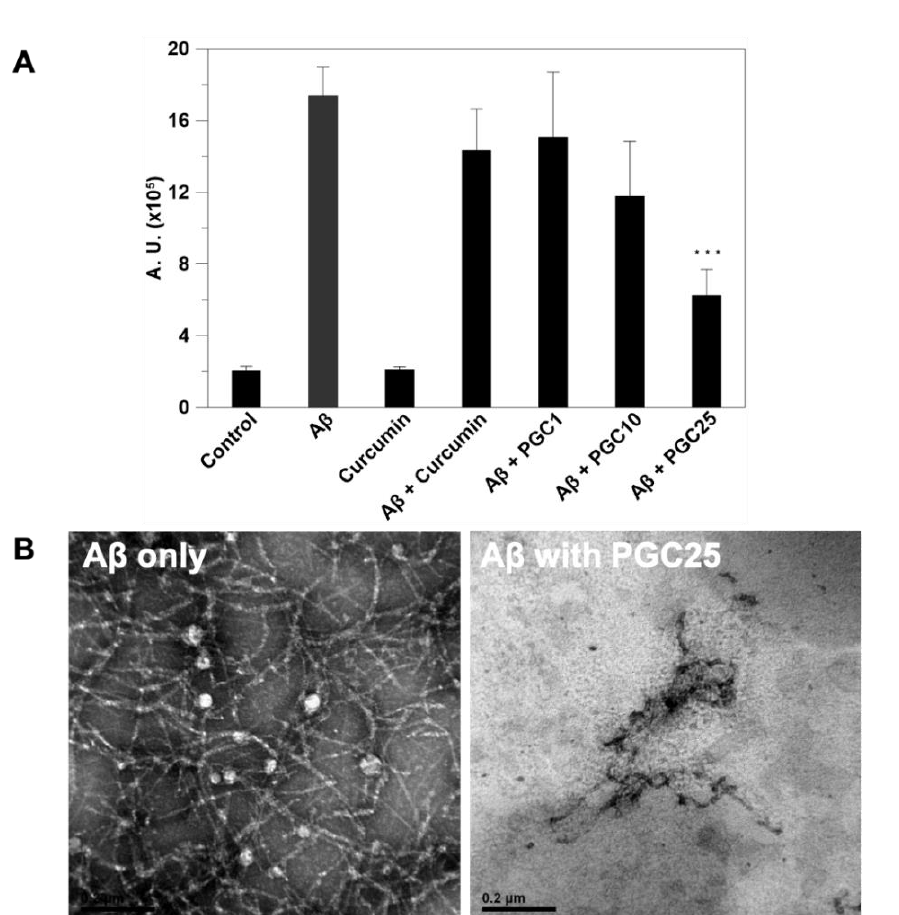
Figure 4. The identification of the inhibition of amyloid fibril aggregation by curcumin and PGC. ( A ) The fluoresce intensity of ThT and ( B ) TEM image of amyloid fibril aggregation (n = 6, *** p < 0.001 compared with the control).